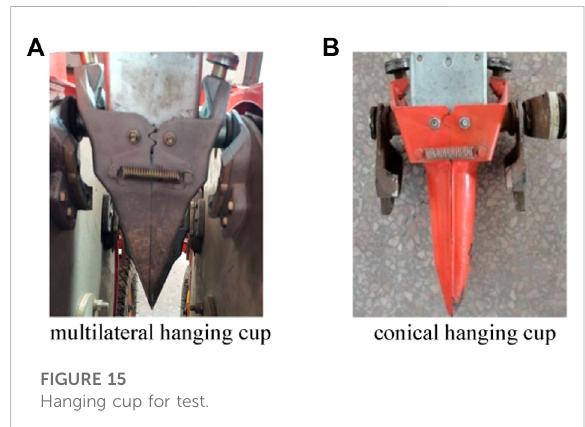
FIGURE 15 Hanging cup for